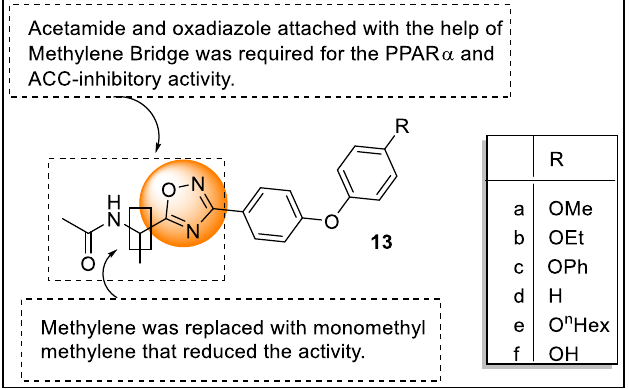
Figure 16. Structural activity relationship of oxadiazole hybrids ( 13 ) as potent PPAR ligands.